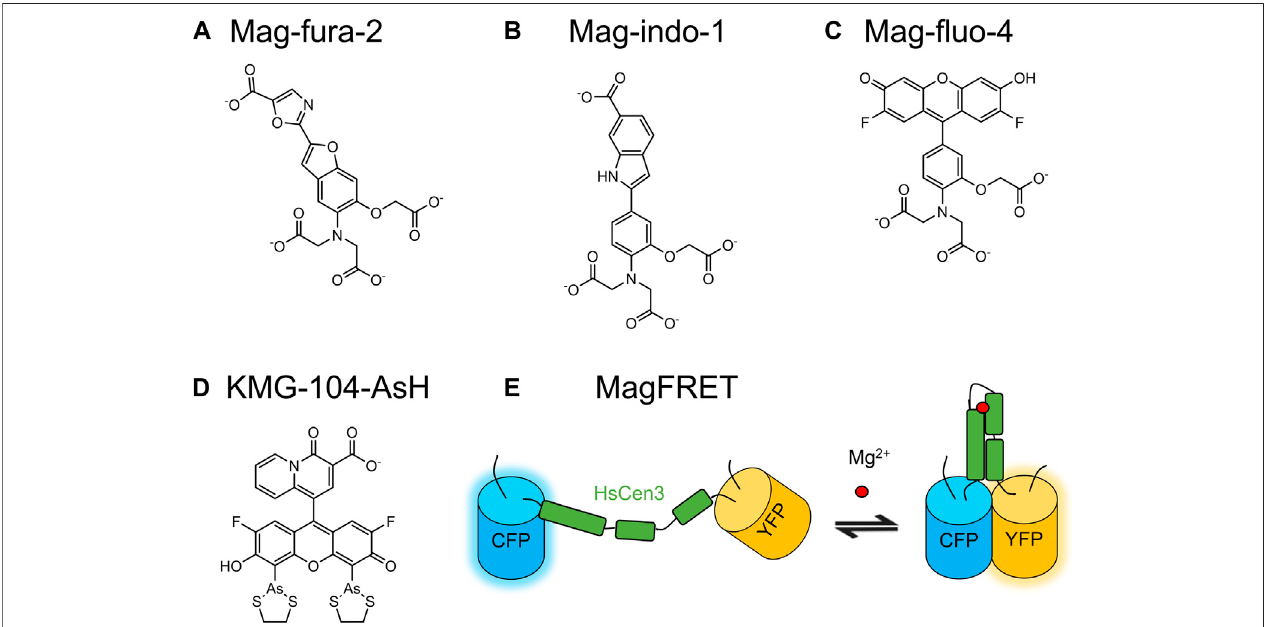
FIGURE 6 | Molecular structures of selected small molecule-based Mg 2+ indicators and schematic representation of a selected GEMI. (A) Mag-fura-2 (Raju et al., 1989), (B) Mag-indo-1 (Morelleet al.,1994), and (C) Mag- fl uo-4 (Shmigol et al.,2001) are based on fl uorophoremoieties thatare identical tothose oftheBAPTA-based Ca 2+ indicators fura-2, indo-1, and fl uo-4, respectively. As a Mg 2+ -binding moiety, they employ o -aminophenol- N , N , O -triacetic acid (APTRA) for Mg 2+ -binding. (D) KMG-104-AsH is a FlAsH-type indicator based on a β -diketone Mg 2+ -binding moiety (Fujii et al., 2014). KMG-104-AsH can be genetically targeted via covalent linking to tetracysteine-tagged proteins through its biarsenical groups. (E) MagFRET is a FRET-based genetically encodable Mg 2+ indicator with the Mg 2+ binding domain from human centrin HsCen3.